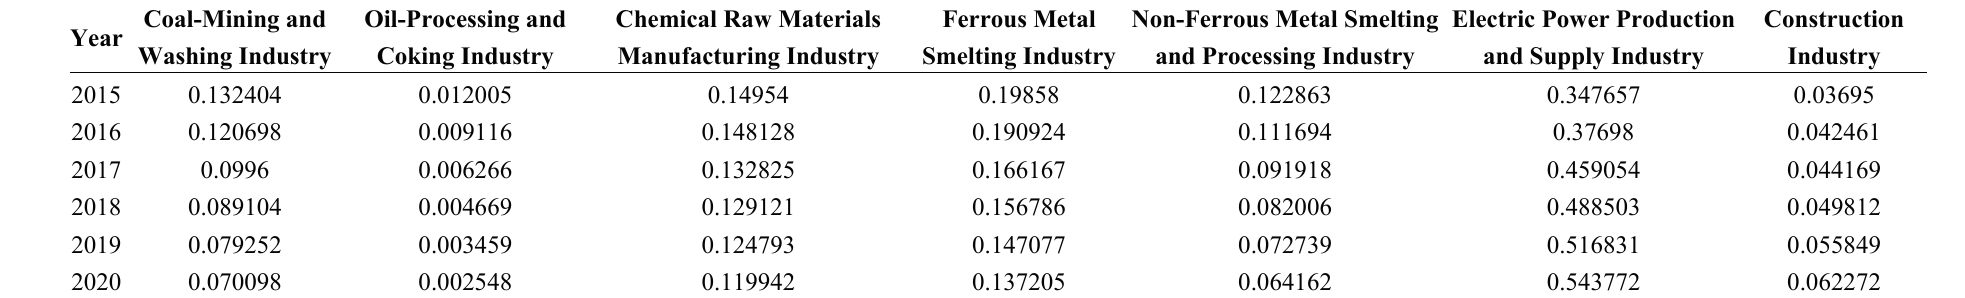
Table 20. Predicted values of the power needed per 10 thousand yuan (10 thousand kilowatt-hours).